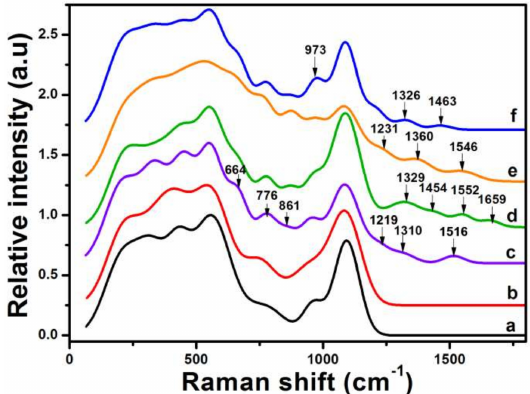
Figure 4. Normalized Raman spectra of ITO electrodes fabricated with ( a ) APPA, ( b ) GO-OA complex liker, ( c ) b-PM, ( d ) SpA, ( e ) anti- E. coli antibodies, and ( f ) E. coli K-12 cells at the top. The b-PM